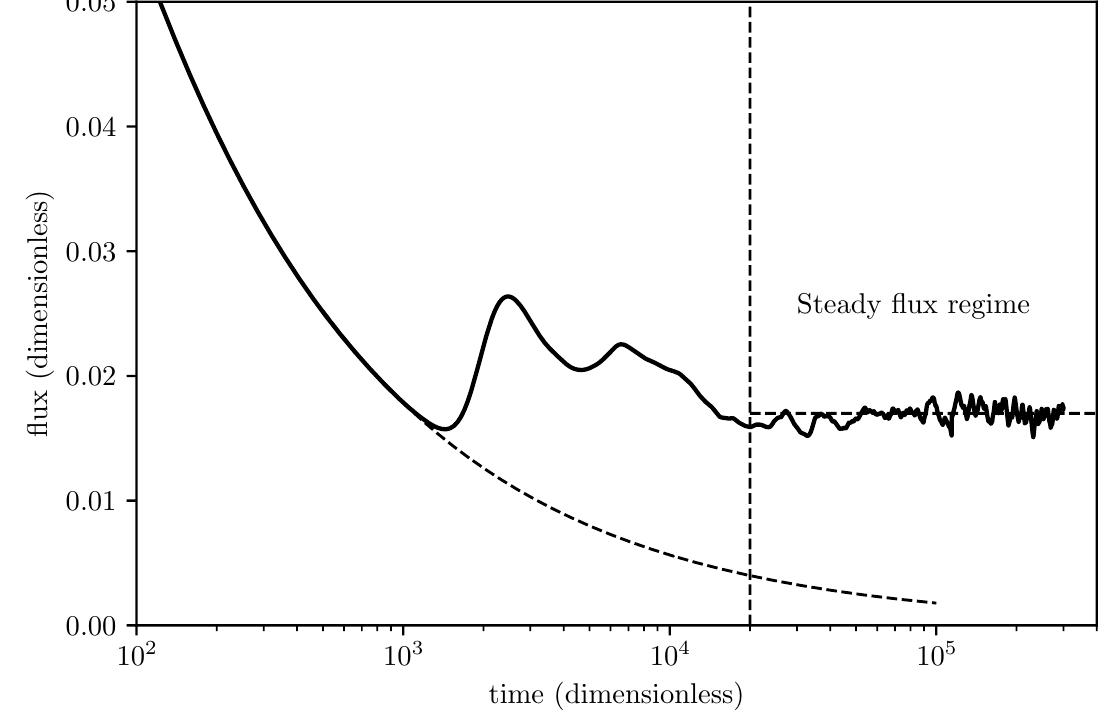
Figure 1. Dimensionless dissolution flux over the top boundary as a function of dimensionless time for Rayleigh number Ra = 20,000 in an isotropic homogeneous two-dimensional model. The dashed line is the purely diffusive profile; the horizontal short-dashed line is the dimensionless average flux in the steady flux regime (0.017) [9]; the vertical dashed line indicates the approximate start of the steady flux regime. For details of the scalings used, see Section 2, and for details of the numerical solution, see Section